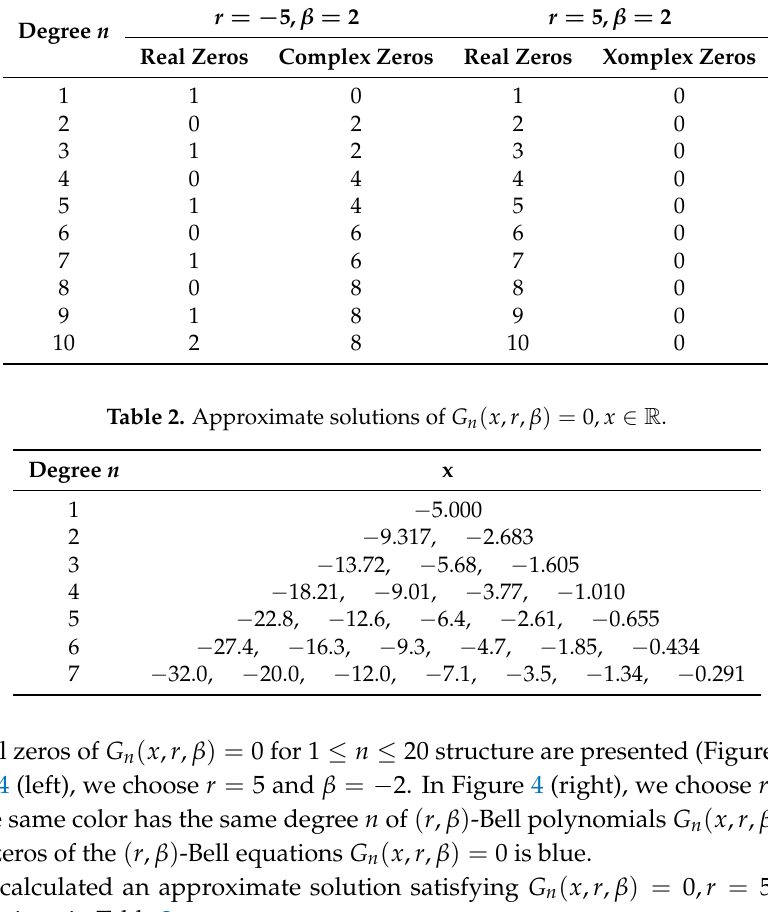
Table 1. Numbers of real and complex zeros of G n ( x , r , β ) = 0